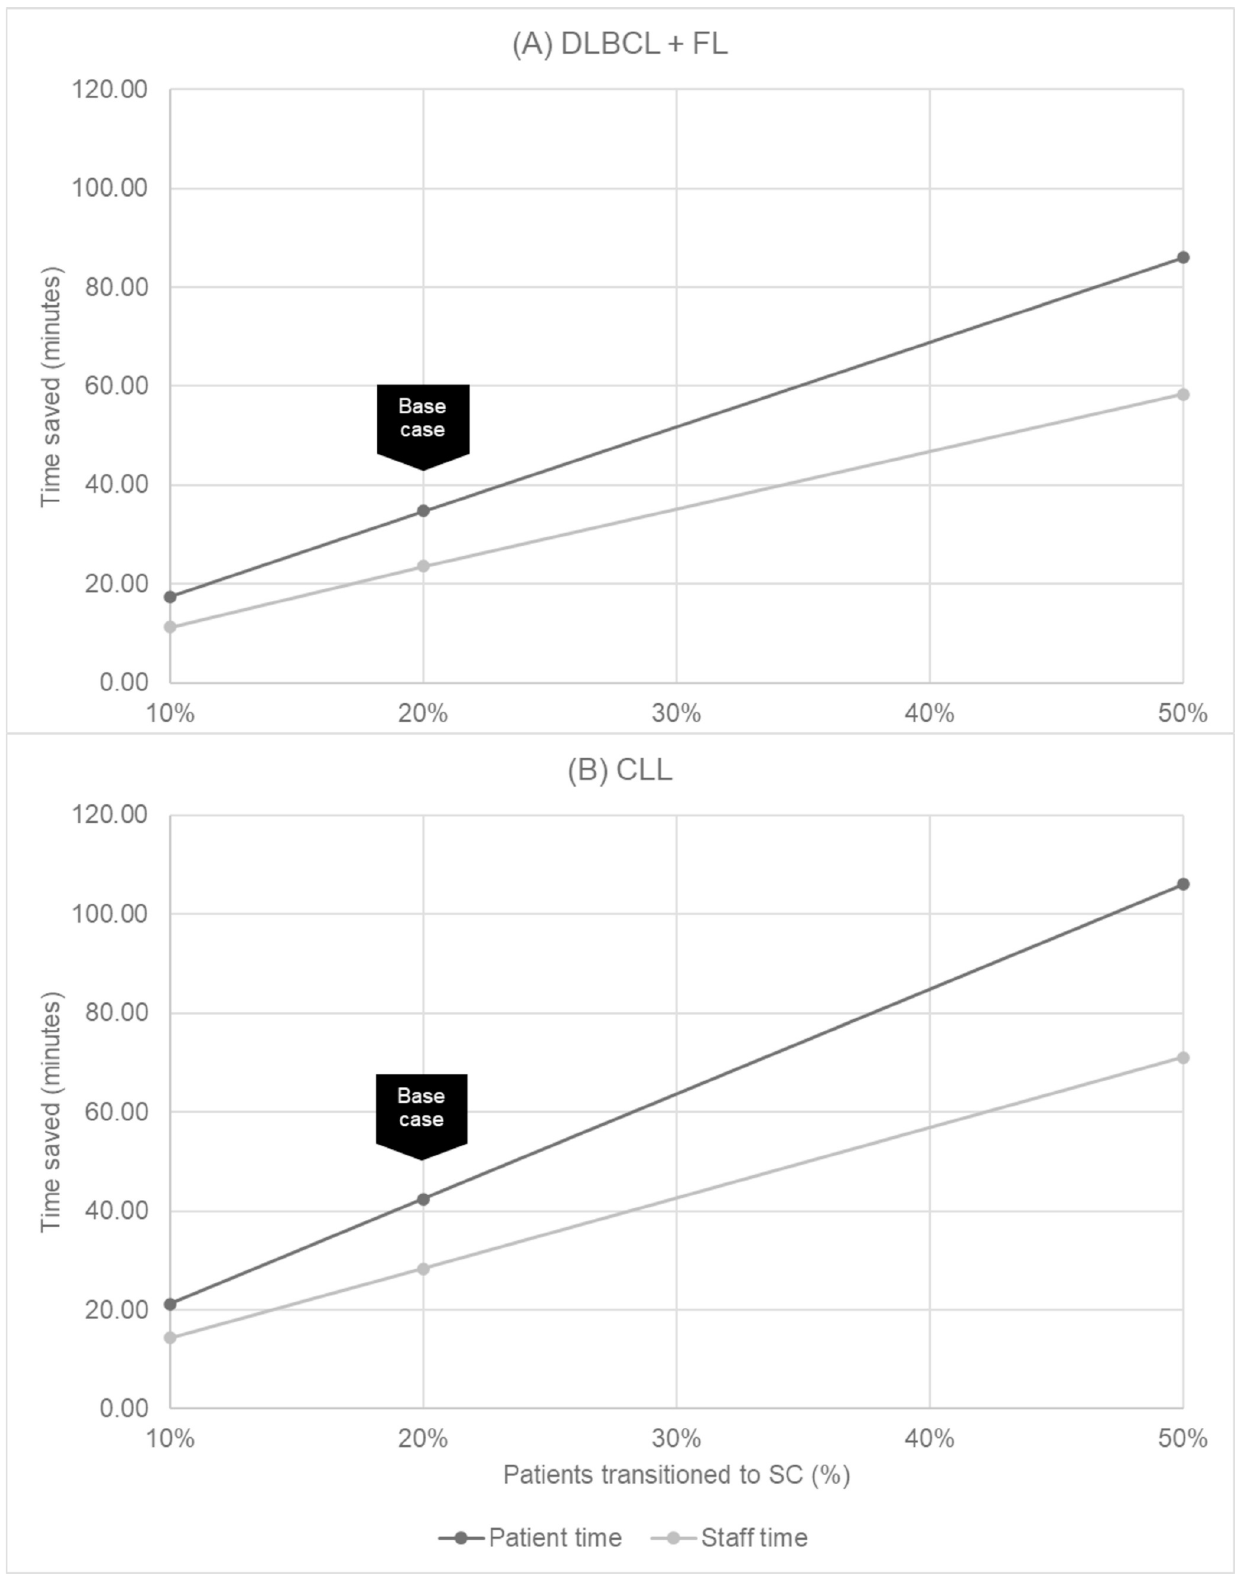
Fig 4. Expected time savings, per indication, per administration. https://doi.org/10.1371/journal.pone.0261336.g004 PLOS ONE | https://doi.org/10.1371/journal.pone.0261336 January 24,